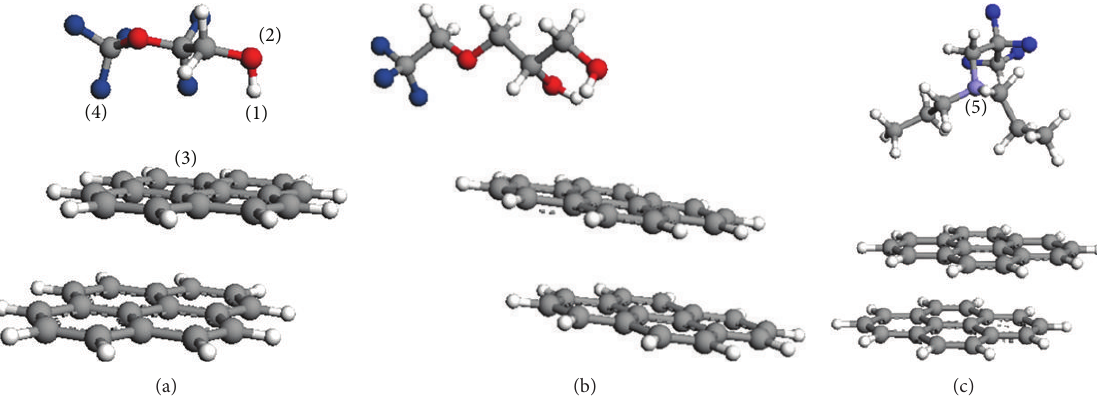
Figure 9: Two-layer graphene with (a) Z-dol, (b) Z-tetraol, and (c) DDPA. Red = oxygen, violet = nitrogen, blue = fluorine, grey = carbon, and white = hydrogen.